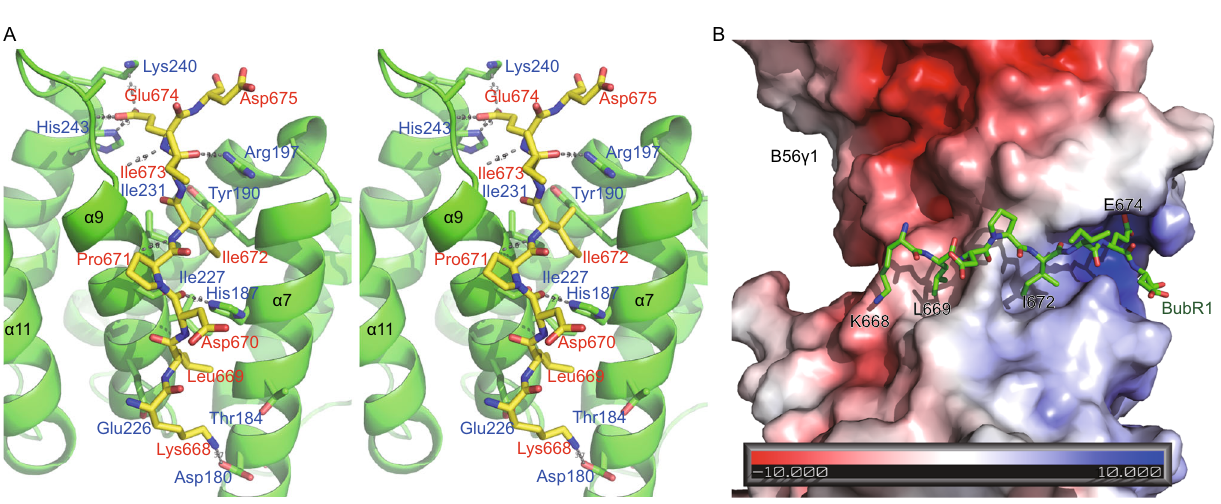
Figure 2. Details of the B56-BubR1 interface. (A) Stereo view of the interface interactions. BubR1 and B56 residues are labelled in red and blue, respectively. (B) The BubR1 KARD domain structure (in sticks) is laid on top of electrostatic surface representation of B56